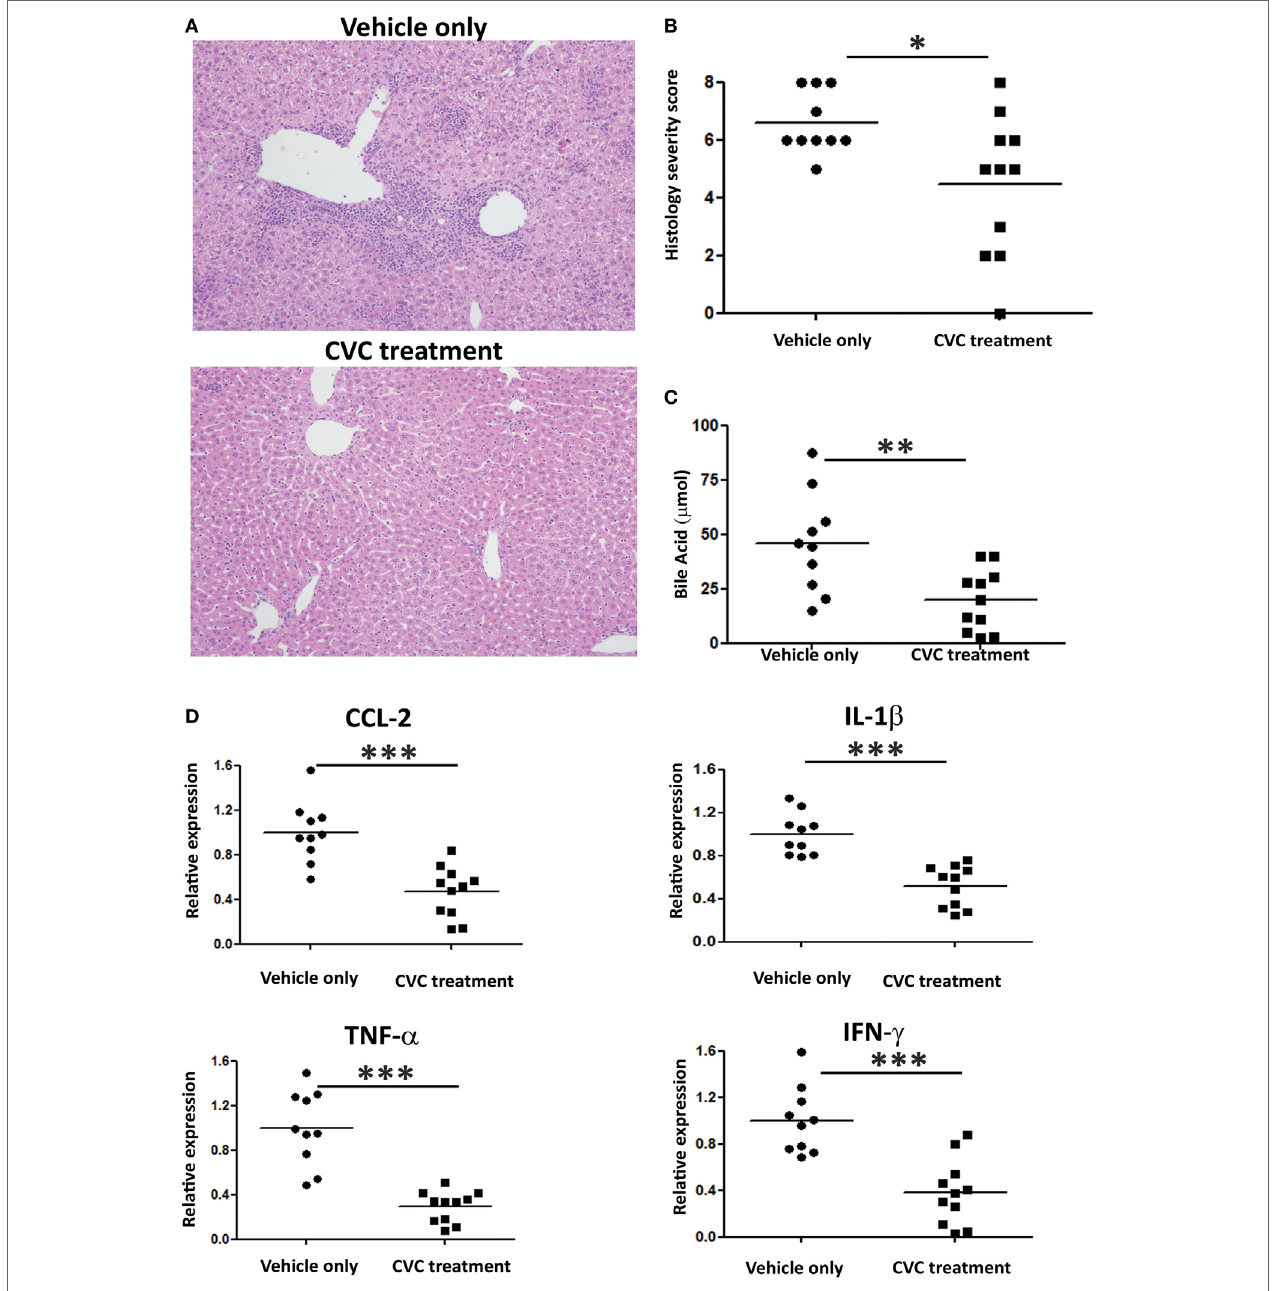
FigUre 5 | CVC treatment ameliorates disease severity in the 2-octynoic acid conjugated to bovine serum albumin autoimmune cholangitis model. (a) Representative liver histology (hematoxylin and eosin staining) of indicated groups of mice, original magnification 40 × . (B) Graphical summary of histological disease severity score. (c) Biochemical profile of total bile acid in indicated mice groups. (D) Graphical summary of hepatic cytokines expression levels of indicated mice groups. All data are presented as mean ( n ≥ 10). Results are representative of two independent experiments. * p < 0.05, ** p < 0.01, and *** p < 0.001 (unpaired Student’s t